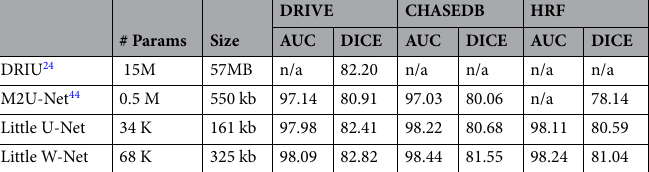
Table 9. Parameters and memory requirements vs performance for several retinal vessel segmentation